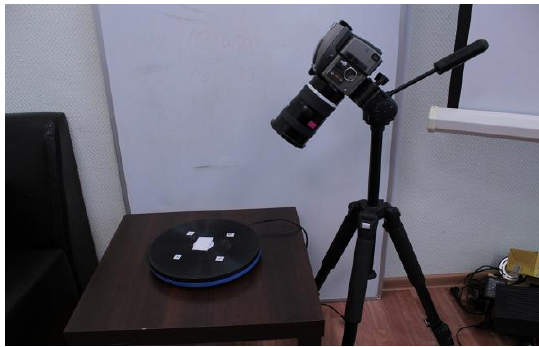
Figure 5. Calibration of the block of photogrammetric deformation marks